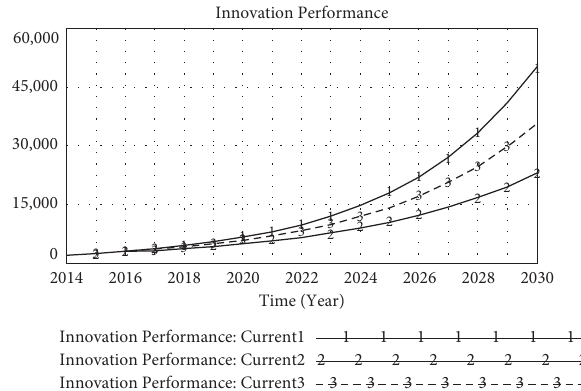
Figure 6: The influence of technical factors adjustment on in- novation performance.